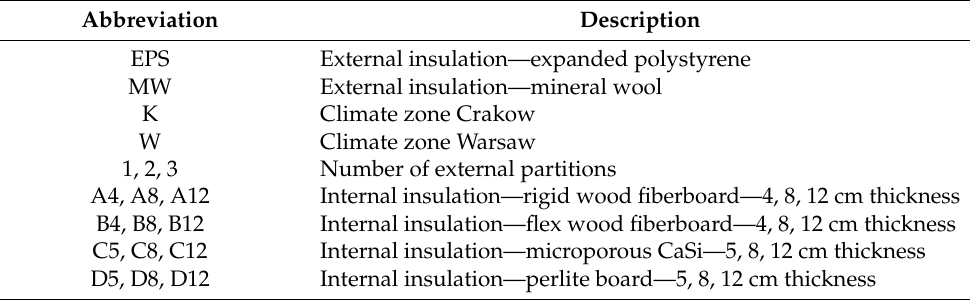
Table 5. Abbreviations used to mark individual